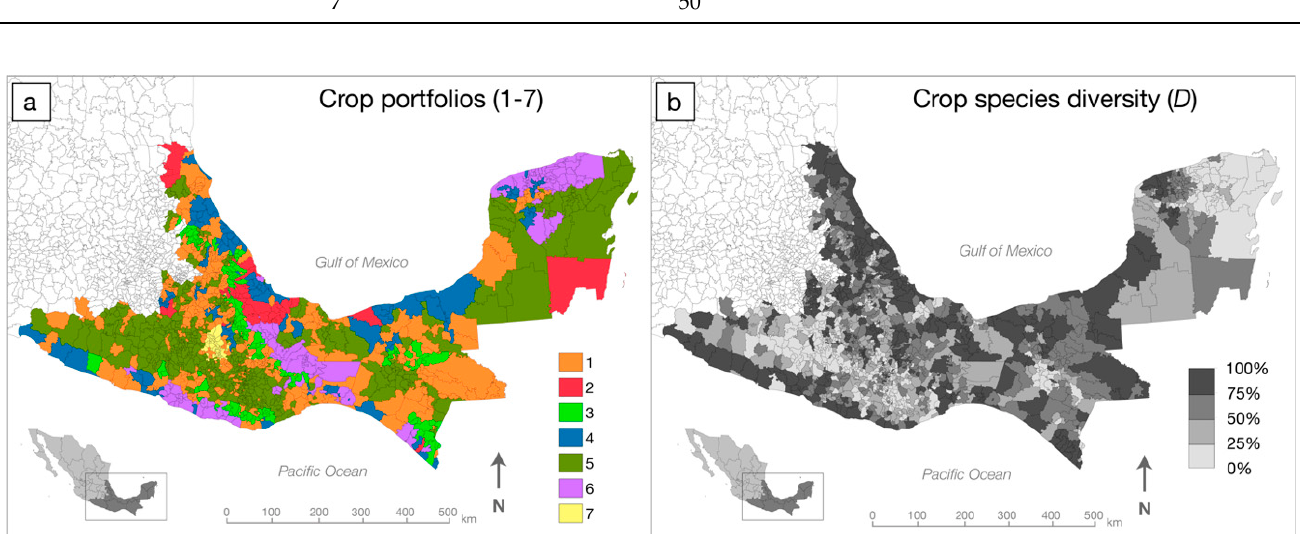
Figure A1. Number of potential K-means clusters and corresponding cubic clustering criterion (CCC) values, which show explained variation (variance-stabilized Rsquare values). Positive CCC values indicate possible clustering and values greater than 2 or 3 represent good clustering (SAS, 2022). Dotted line shows selection cutoff (elbow method) after also considering model parsimony and diminishing returns.